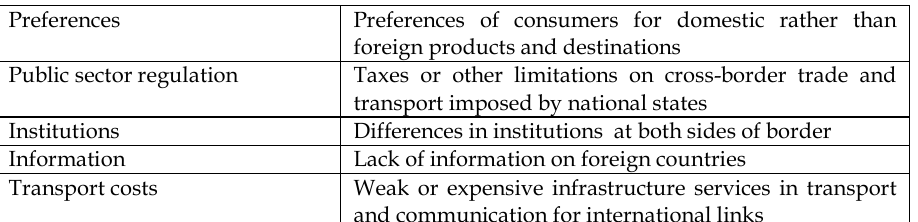
Table 1. Barrier effects of